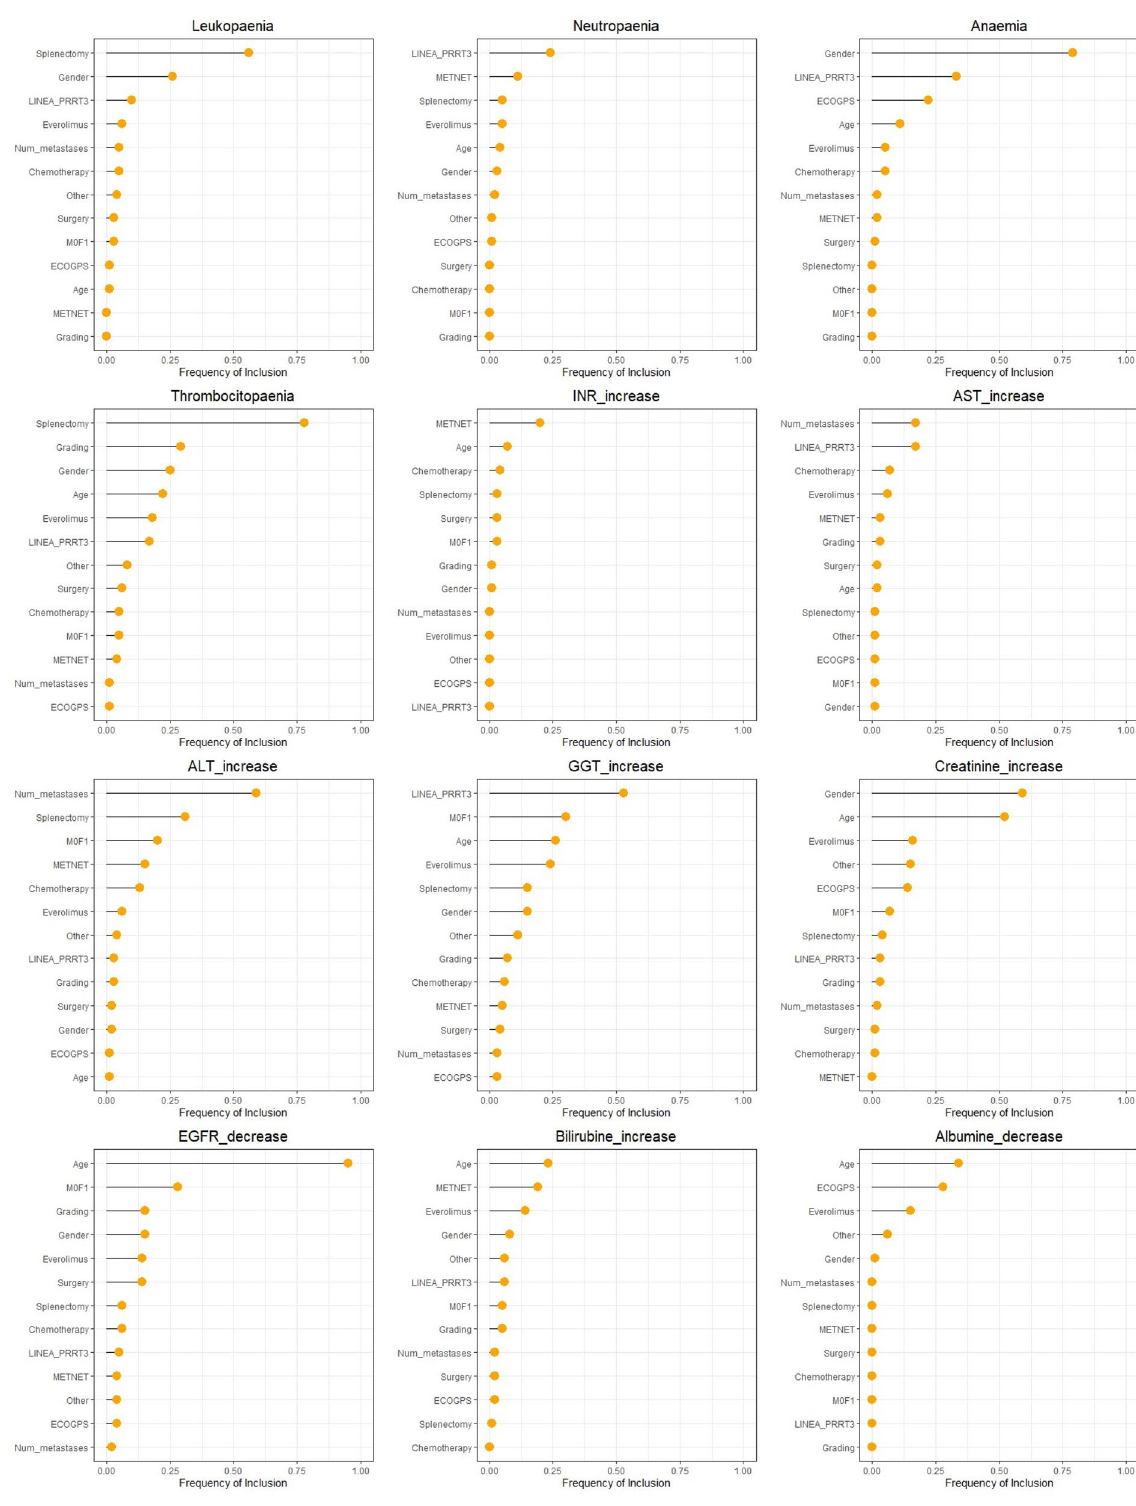
Figure 1. Bootstrap results: frequency of inclusion of the covariates in the FLIC model, by outcome. Grading: WHO